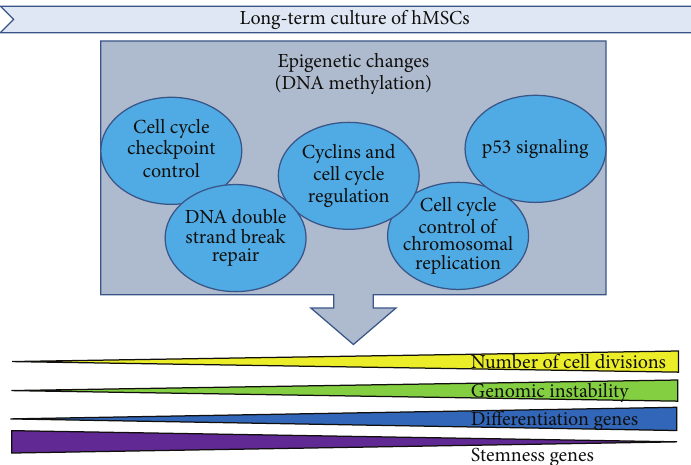
Figure 2: Epigenetic changes (in particular DNA methylation) at specific gene promoters during long-term culture of hMSCs may regulate processes like senescence and proliferation but also genomic stability. Many statistically significant pathways involved in methylation variations between early and late passages of Figure 1 concern cell cycle regulation, DNA repair, and cancer (light-blue